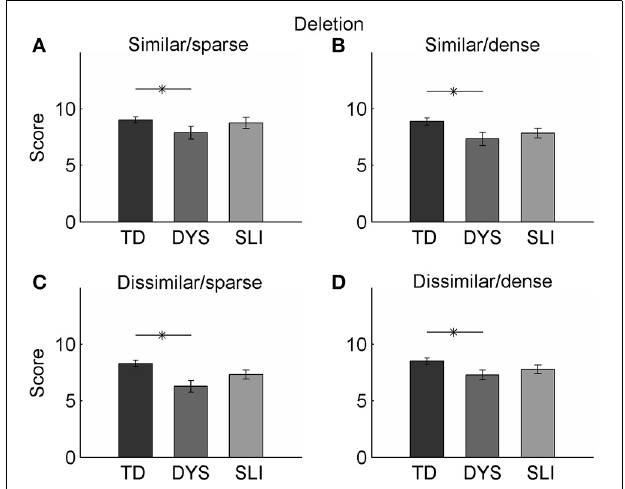
FIGURE 2 | Effect of similarity and density on deletion tasks in children with SLI. Similarity did not seem to affect level of accuracy when words were from sparse neighborhoods. When words were from dense neighborhoods, similarity did play a significant role; dissimilar sounding words were easier than similar sounding words.